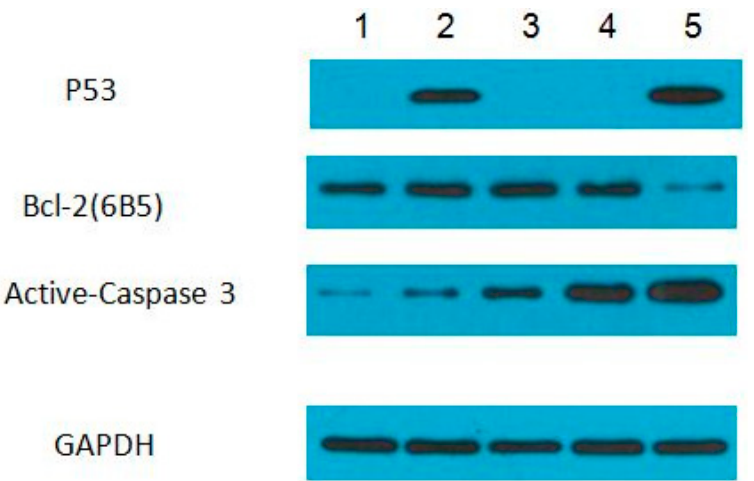
Figure 4. Cell cycle of ZFL under the inducing of PFOA and PFOS. The experiment was repeated three times. ** p < 0.01.